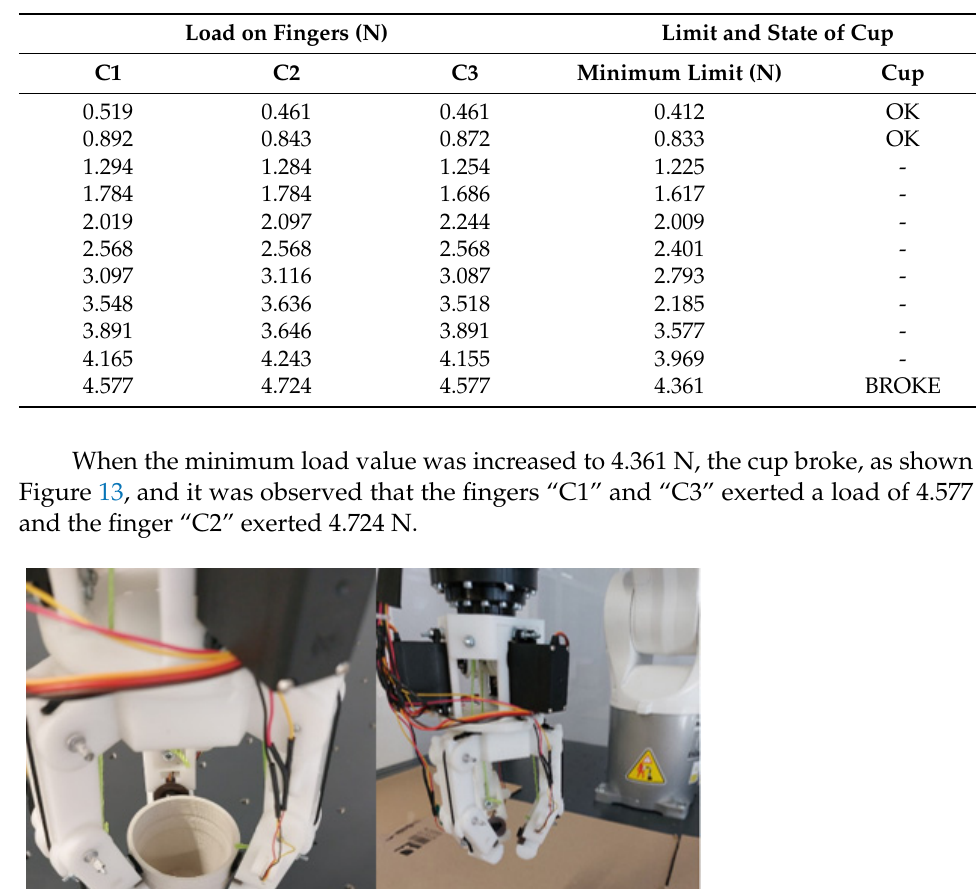
Table 2. Load values of the stiffness test. Source: (own).